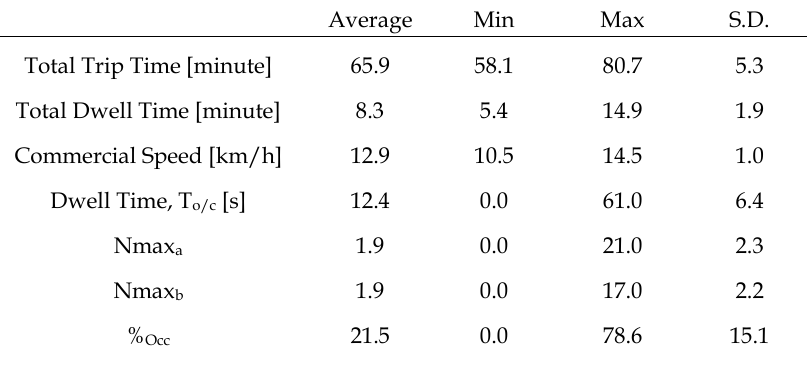
Table 3. Table 3: Descriptive statistics for main relevant variables.